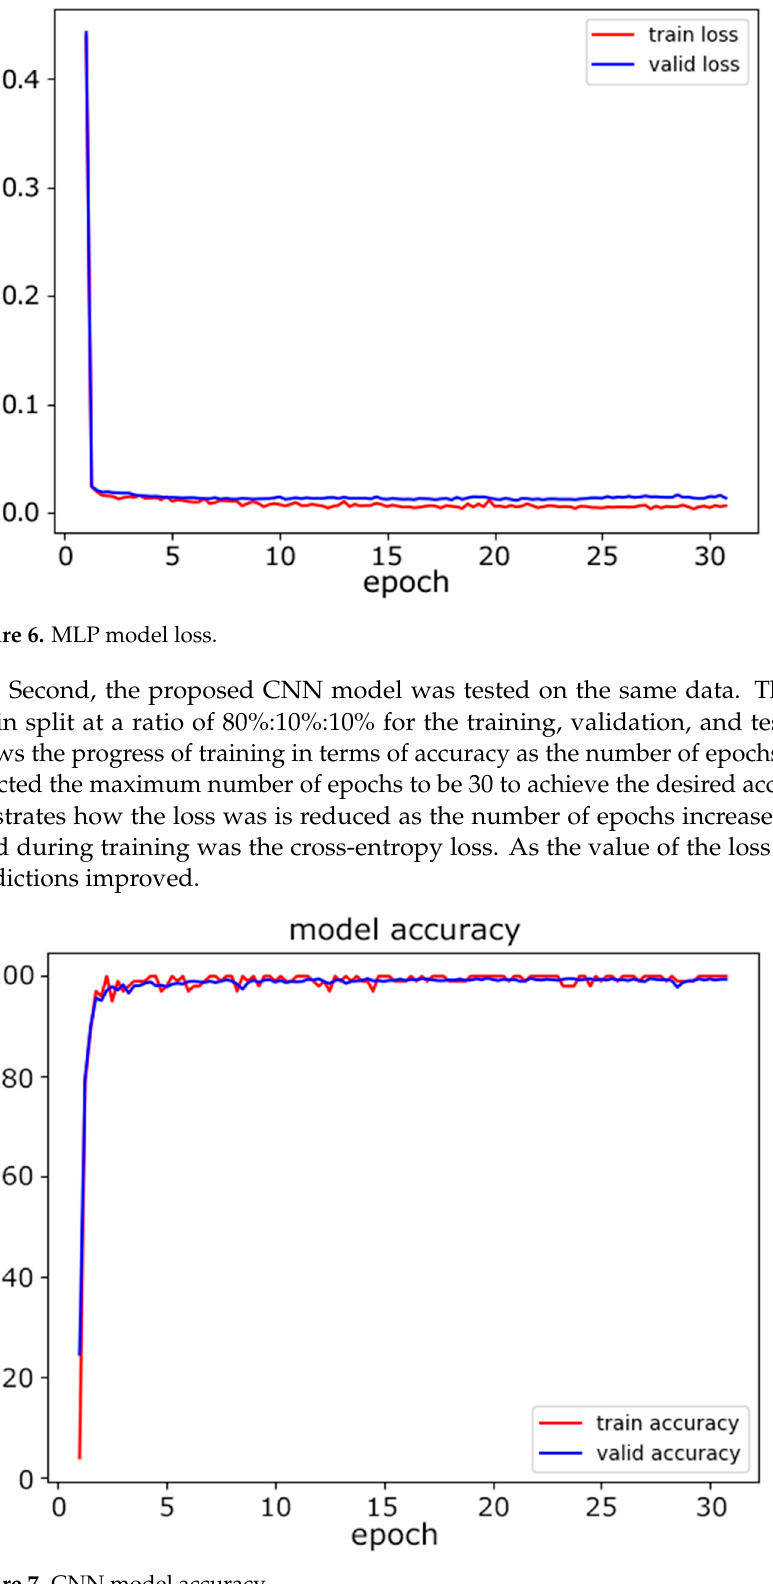
Figure 5. MLP model accuracy.